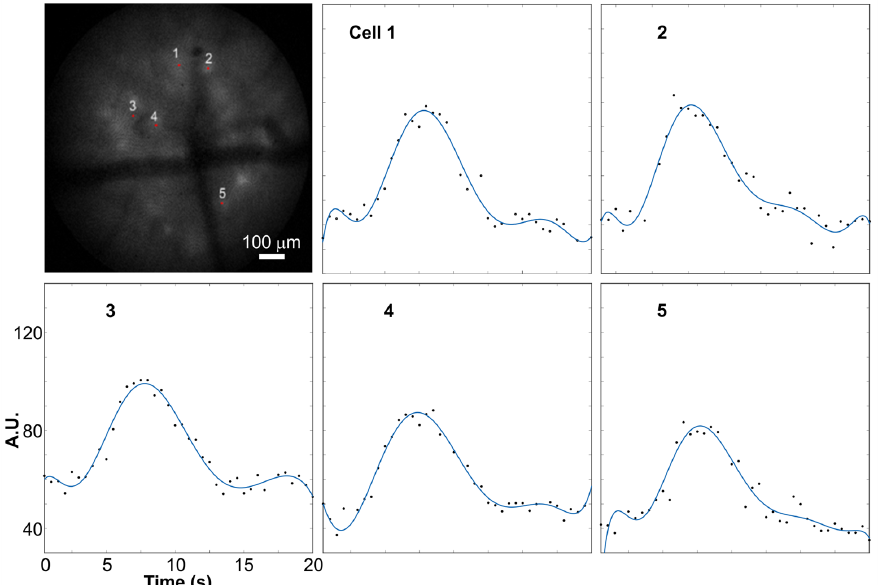
Figure 5. Calcium dynamics in astrocytes. Fluctuation of the intensity versus time for the five active regions of Set 1. Individual astrocytes highlighted in image in upper left. All plots have the same coordinate axes.